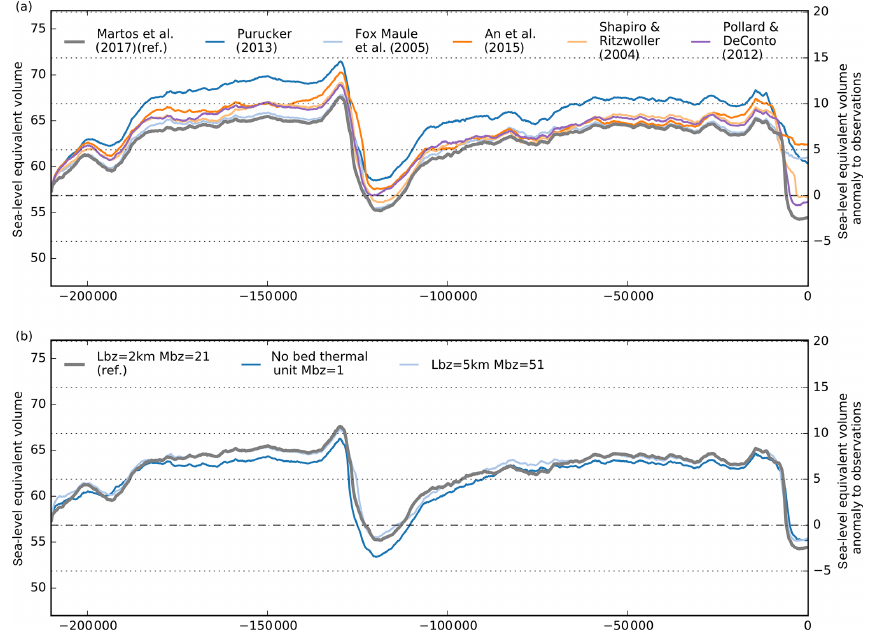
Figure 12. (a) Simulation results for different basal heat-flux distributions (Martos et al., 2017; Purucker, 2013; Fox Maule et al., 2005; An et al., 2015; Shapiro and Ritzwoller, 2004; Pollard and DeConto, 2012a). The range of the resulting ice volumes above flotation is rather small, with less than 3mSLE on average. In interglacial periods the divergence in ice volume can reach more than 8mSLE. (b) Sensitivity of transient ice volume to varied thickness of the bed thermal layer (model option “Lbz” in km, with “Mbz” the number of equidistant vertical grid subdivision of the layer; see legend). Reference thickness is 2km (grey), which yields similar results to a 5km thick bed thermal layer (light blue). Not taking any bed thermal unit into account leads to slightly lower ice volumes, in particular during LIG (blue).